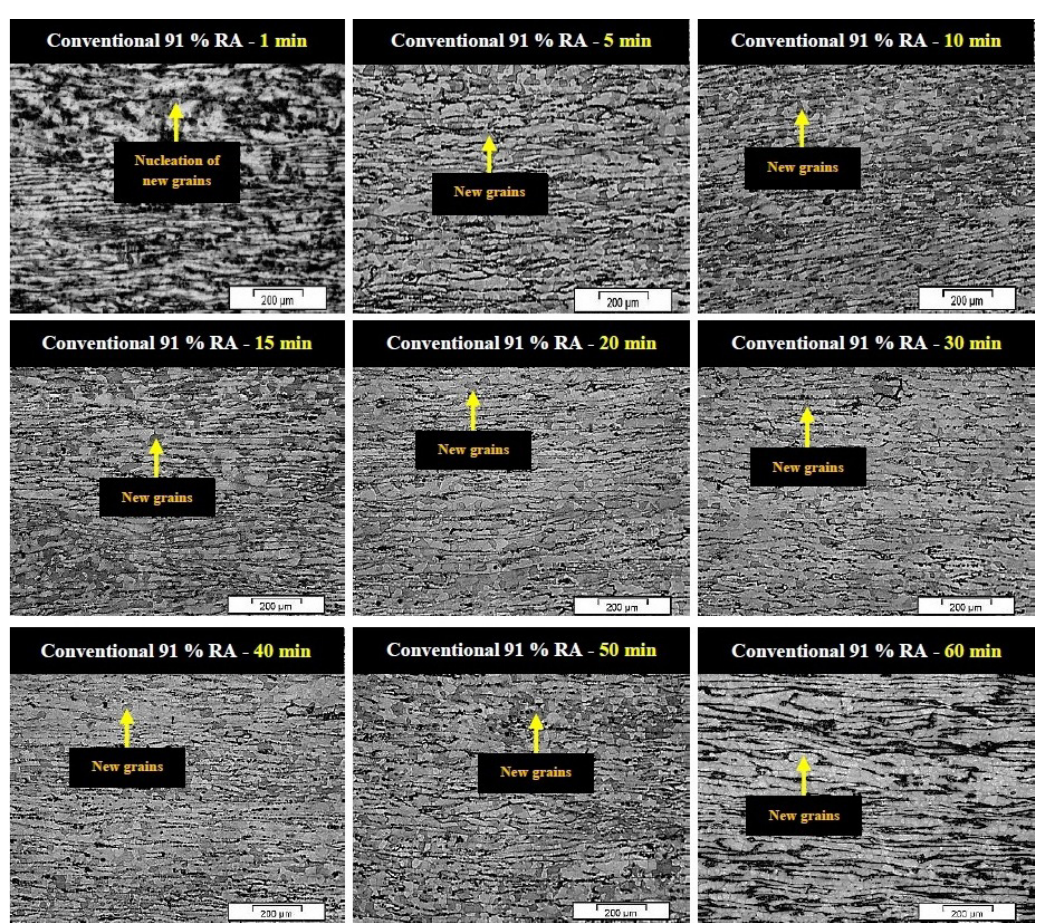
Figure 8. Recrystallization kinetics at 350 ºC of the Al4.5wt%Cu sample with 91% of RA conventionally